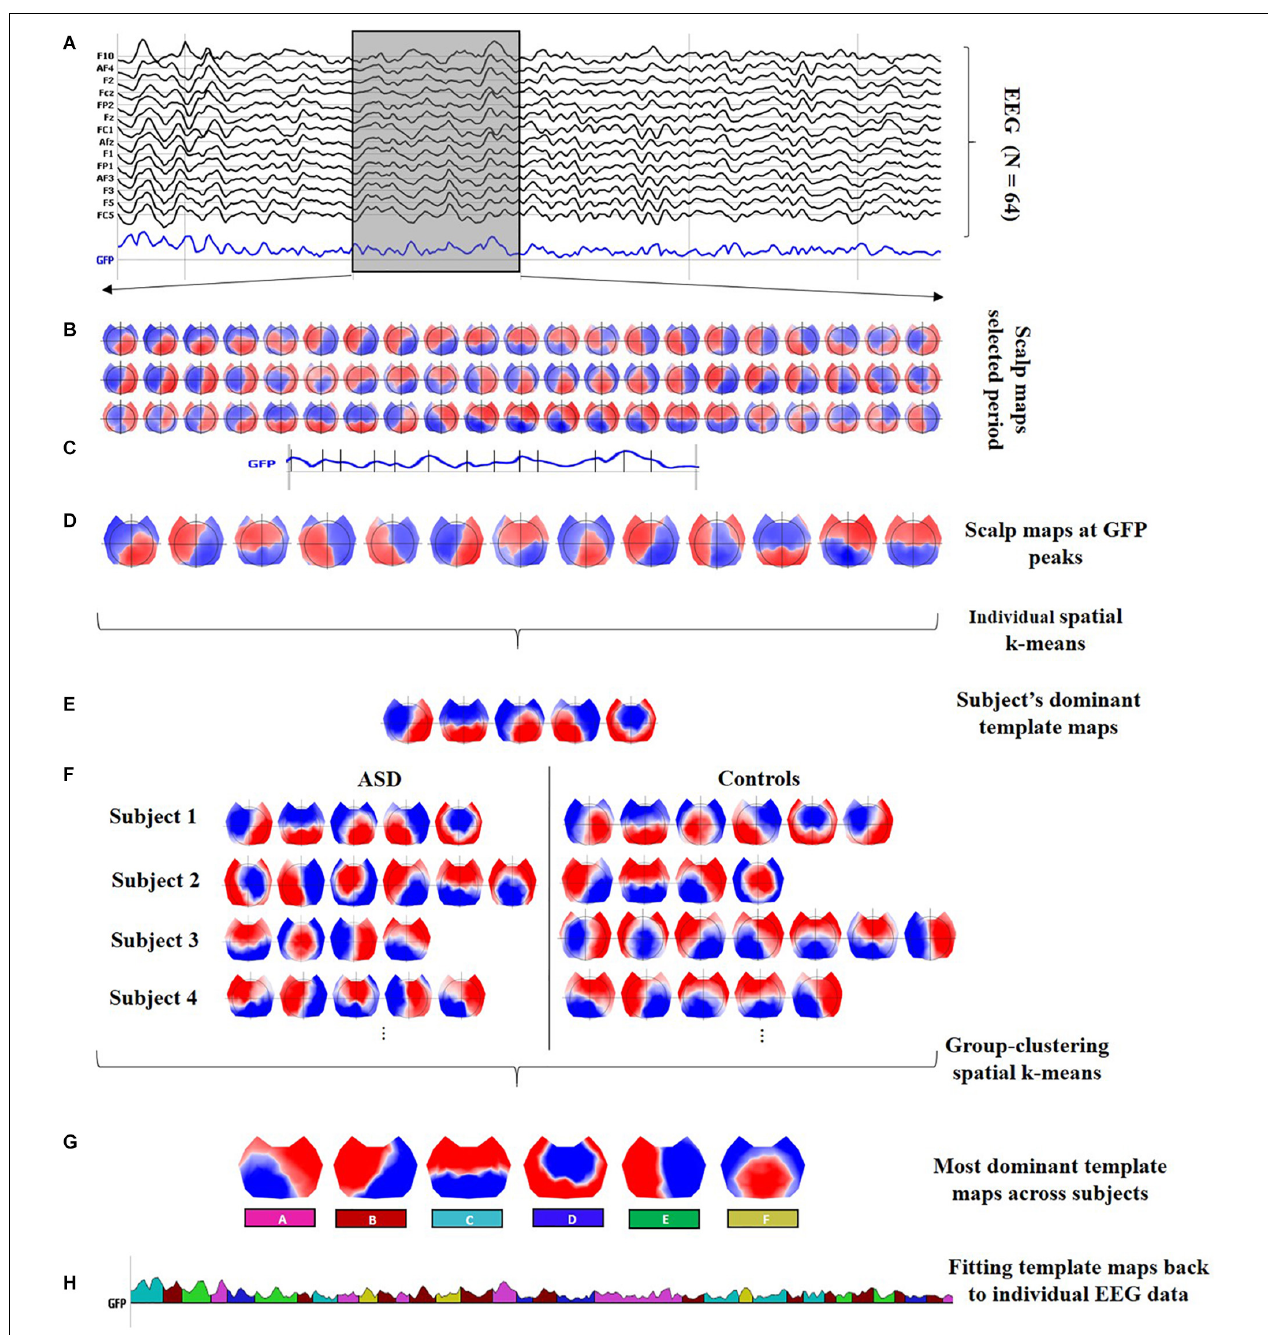
FIGURE 1 | Microstate analysis. (A) Preprocessed EEG recordings down-sampled at 125 Hz, illustrating 2 s of data for one subject (vertical gray lines represent intervals of 0.5 s). Black curves correspond to 14 out of the N = 64 channels; the blue curve shows the global field power (GFP). Moreover, a 0.5-s interval is highlighted in the gray shaded area to display a zoom-in of the topographical data. (B) Sixty-three scalp maps from the 0.5-s interval, i.e., one per time frame. (C) Identification of the local peaks, displayed as vertical black lines, at the GFP curve within the 0.5-s interval. (D) The scalp maps corresponding to the local GFP peaks were submitted to a spatial k-means cluster analysis. (E) The most dominant template maps for the subject were selected based on the meta-criterion. (F) Steps (A) to (E) were repeated at individual level to obtain the set of the most dominant spatial maps for every subject. The individual sets with the dominant spatial maps for all subjects were submitted together to a group clustering analysis. (G) The six classes are the most dominant template maps after the group clustering spatial k-means across all subjects. The number of clusters was selected based on the meta-criterion. (H) A microstate sequence for the same subject as in (A) . The six classes are fitted back to the original EEG data of every subject, labeling each time frame with only one microstate, which is selected considering the highest spatial correlation between the scalp topography and every class (winner-takes-all). The microstate sequence is used, for every subject, to extract the temporal parameters and statistical